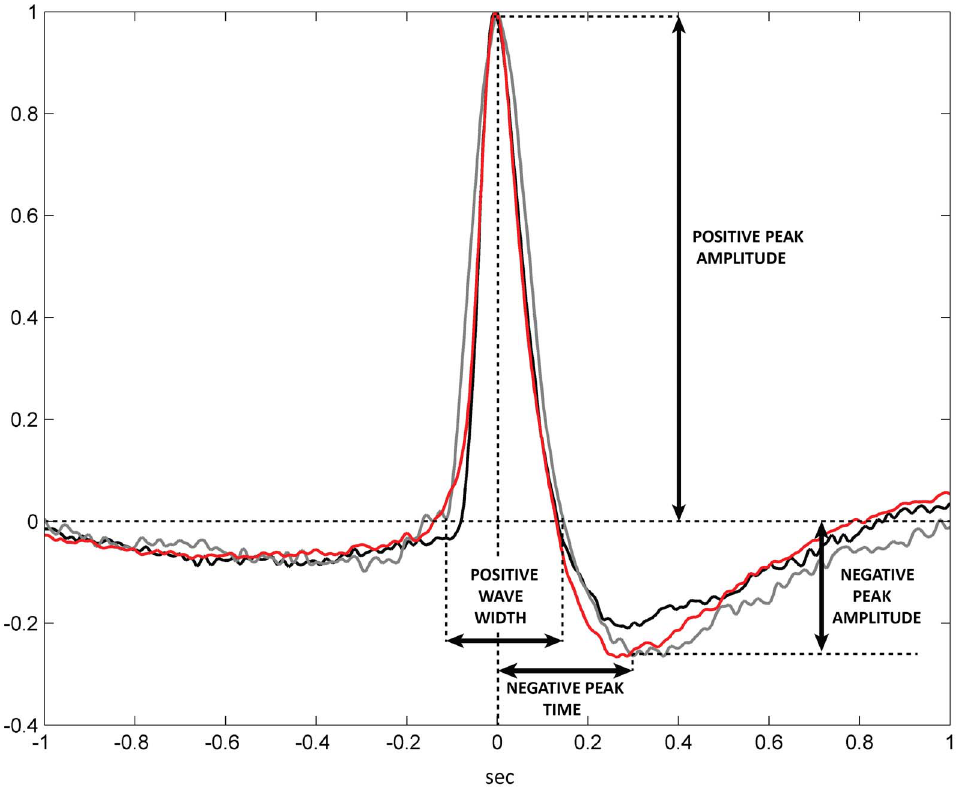
Figure 1. Group-averaged EOG blinks. In the present figure, group-averaged EOG blinks are presented. The red trace refers to CTRL subjects, the gray trace to MCS and the black one to VS/UWS. For each subject the mean blink was normalized to its maximum amplitude. Group-averages were obtained mediating among subjects of the group. In the figure the four features chosen to describe the blink morphology are presented for illustrative purposes (positive peak amplitude, positive wave width, negative peak amplitude, and negative peak time location). Note that statistics on the presented features were perfomed on raw (non-normalized) blinks.